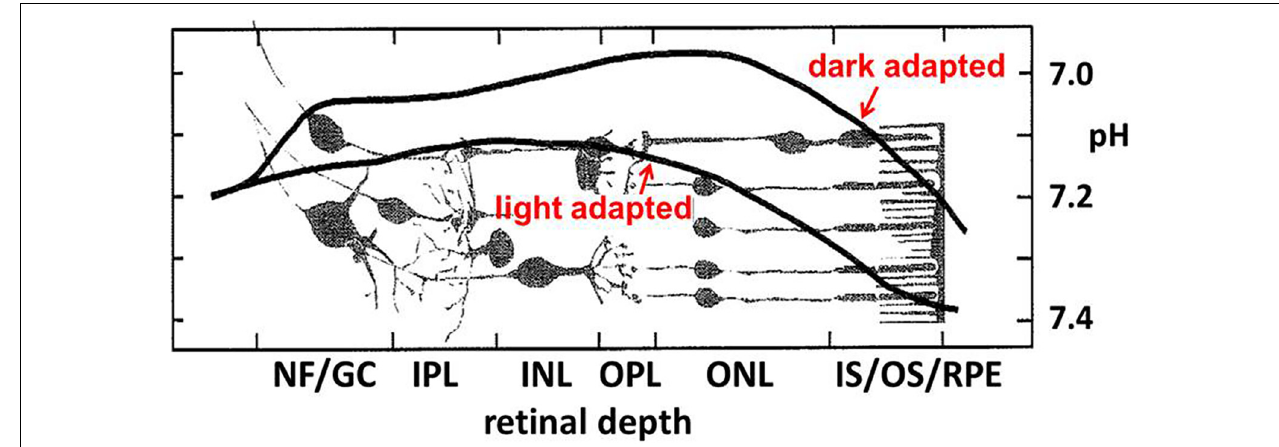
FIGURE 2 | Near the photoreceptor layer, there is a notable light vs. dark difference in bulk pH o in the outer retina. In the darkness, when rod and cone photoreceptors are maximally depolarized for an extended period, the pH becomes more acidic. Figure adapted from Yamamoto et al. (1992).